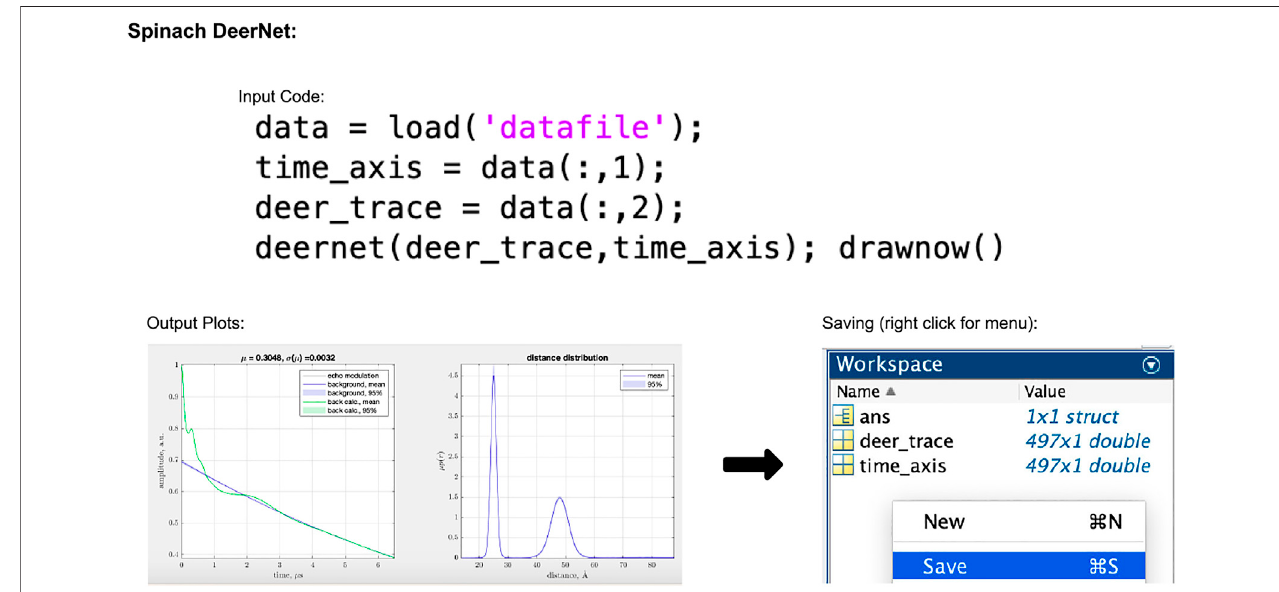
FIGURE 5 | Spinach 2.6.5625 DeerNet work fl ow. The package is Matlab-based and available on all operating systems. Data set shown is simulated noiseless, which was an ASCII fi le. For users using Elexsys type fi les, the fi rst three lines of the input code should be replaced with the single line “ [deer_trace, time_axis] = elexsys2deernet ( ‘ data fi le ’ ) ” . Note that no fi le extensions should be added to the end of “ data fi le ” when using this function. In the output plot panel, the numbers above the DEER trace signi fi ed by μ and σ ( μ ) represent the modulation depth, and the standard deviation in the modulation depth,